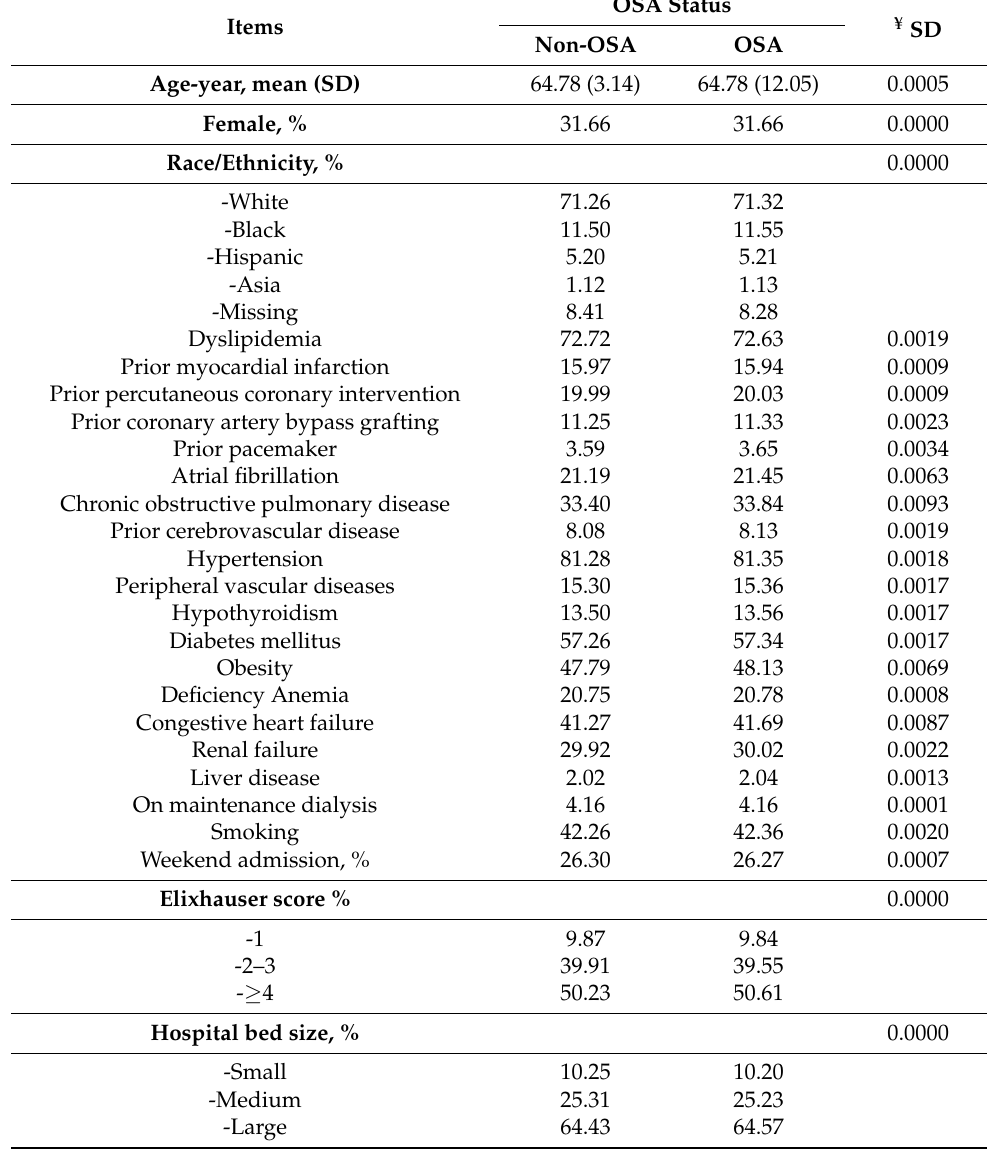
Table 1. Propensity score-standardized morbidity ratio (SMR) weighted baseline characteristics of patients with NSTEMI by OSA